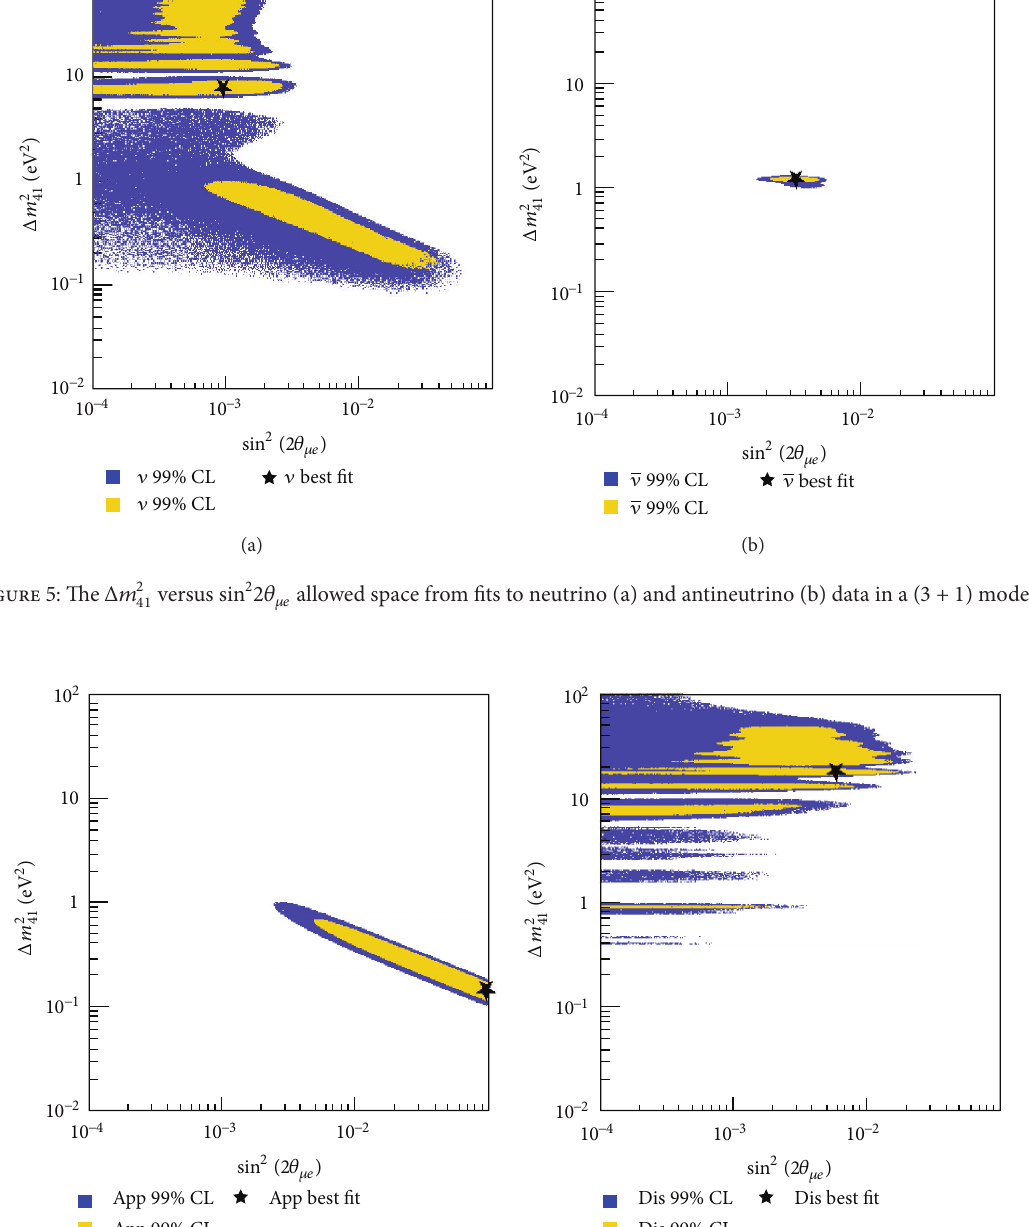
(4) for the global best-fit parameters, which corresponds to a 𝜒 2 -probability of 0.07%. This is one of the first indications that the MiniBooNE neutrino data has some tension with the other